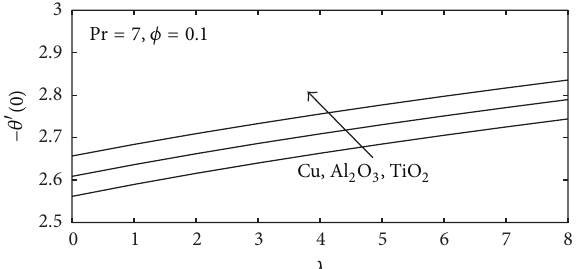
Figure 5: Variation of −𝜃 󸀠 (0) with 𝜆 for different types of nanopar- ticles when Pr = 7 and 𝜙 = 0.1 .